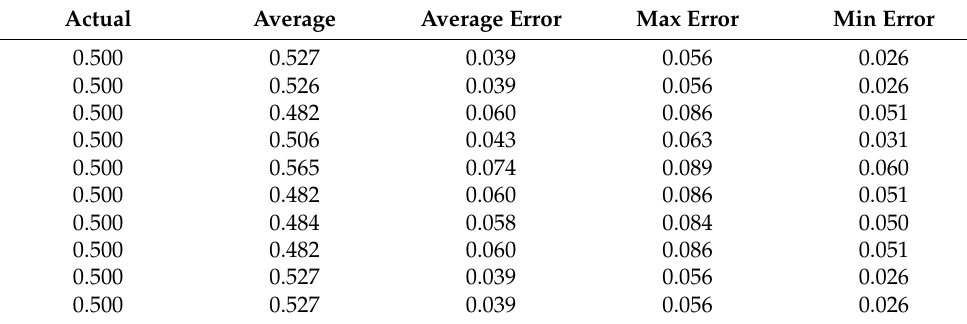
Table A81. Set 2, trials 1–10 data (all 0.5 PR values).